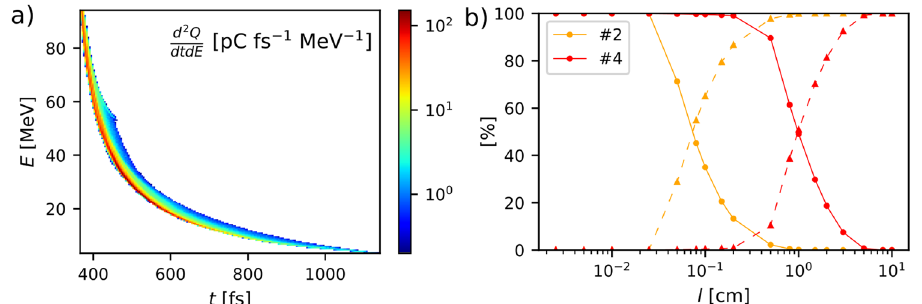
Figure 5. Proton transport through a Pb converter. ( a ) Time-resolved energy spectrum of the protons crossing the virtual detector as recorded in SLT run #2 (see Table 1). ( b ) Dashed lines: dissipated fraction of proton beam energy due to inelastic collisions as a function of the Pb converter length l , in SLT case #2 (orange) and DLT case #4 (red). Solid lines: transmitted fraction of proton beam energy in SLT case #2 (orange) and DLT case #4